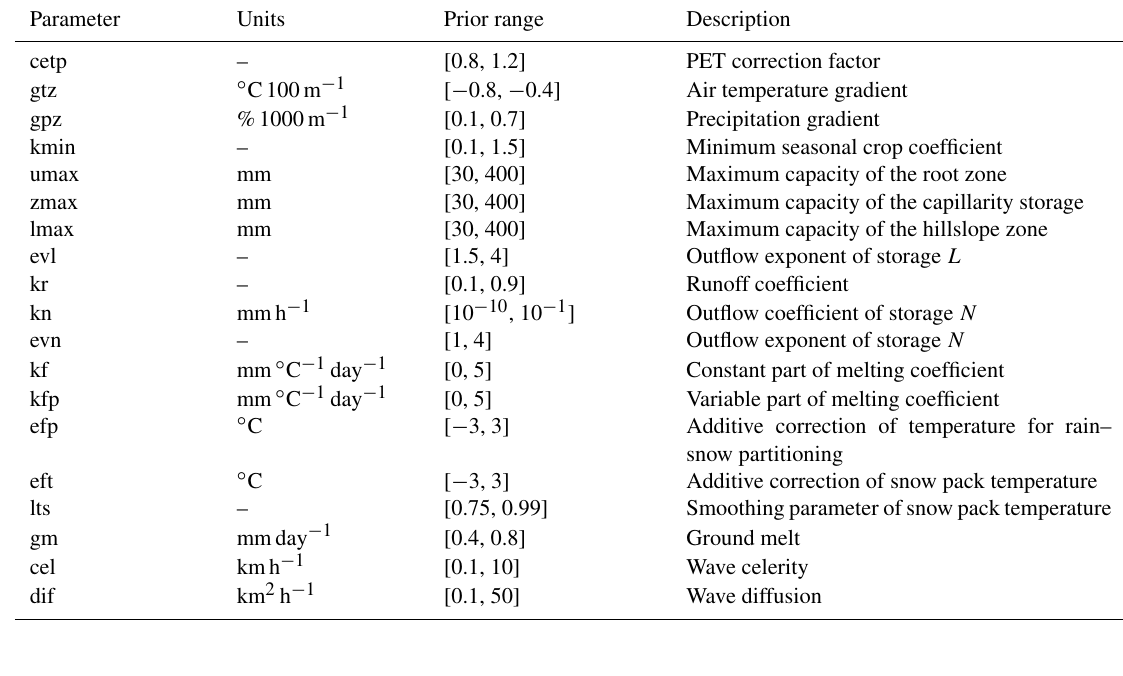
Table A1. MORDOR SD free parameters, units, range and description. Parameter Units Prior range